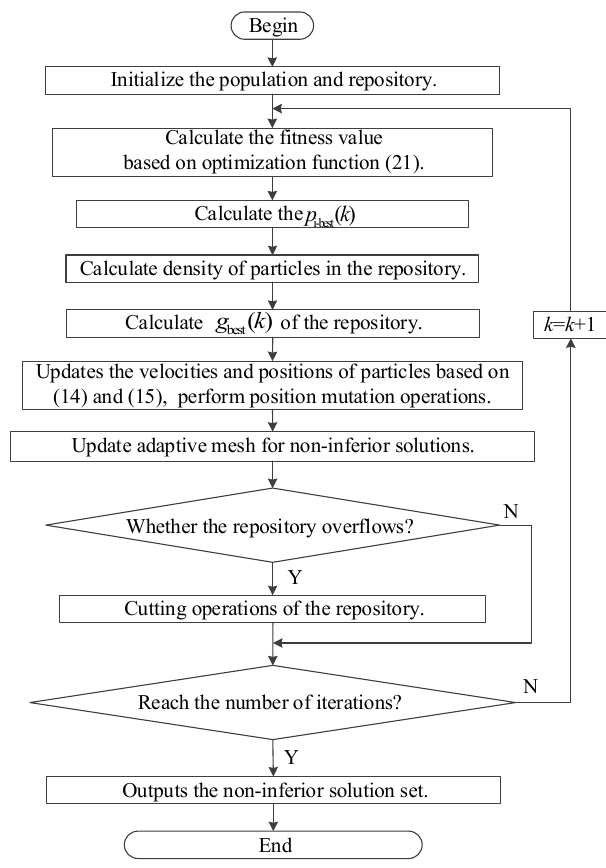
Figure 4. Flowchart of the MOPSO algorithm. Table 2. The main parameters related to the MOPSO algorithm.